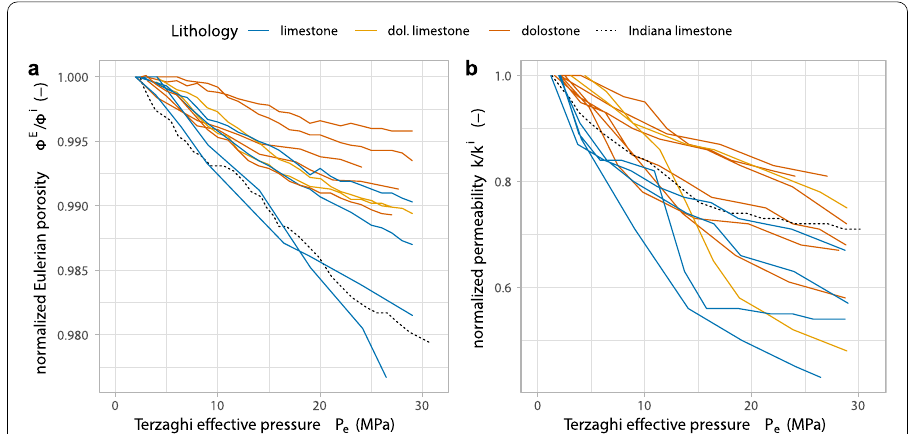
Fig. 9 Stress-dependent porosity and permeability reduction of all investigated samples during hydrostatic testing. a Porosity reduction is characterized by the Eulerian porosity Φ E and normalized to the initial porosity Φ i for comparison. With increasing effective stress, Φ E decreases almost linearly. The porosity reduction is relatively small (< 2.5%) and for limestone samples generally more pronounced than for dolomitic limestone and dolostone. b Stress-induced reduction of permeability k (normalized to initial permeability k i ) is significantly stronger than for porosity indicating a higher stress sensitivity of permeability (up to 57%). The “Indiana limestone” data were taken from Meng et al. (2019) for comparison of the results and show a